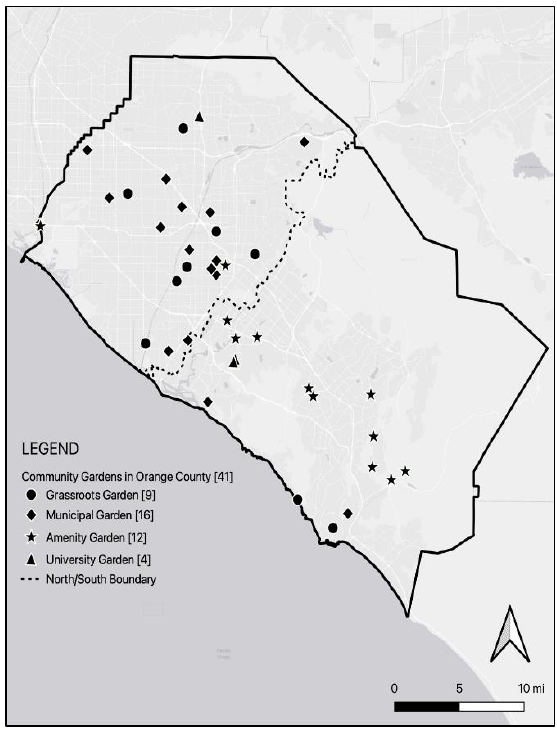
Figure 1. Community Garden Types and Locations in Orange County,